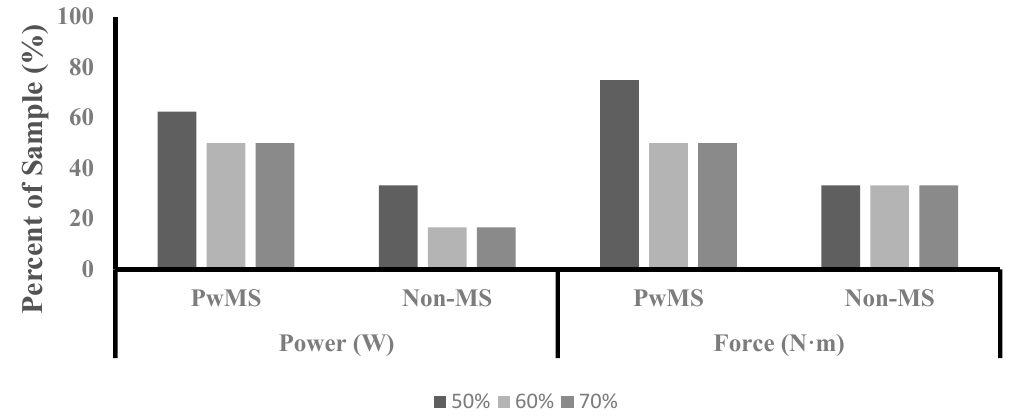
Figure 4. Percent of sample that exhibited ≥ 10% asymmetry. Data displayed as frequency data.